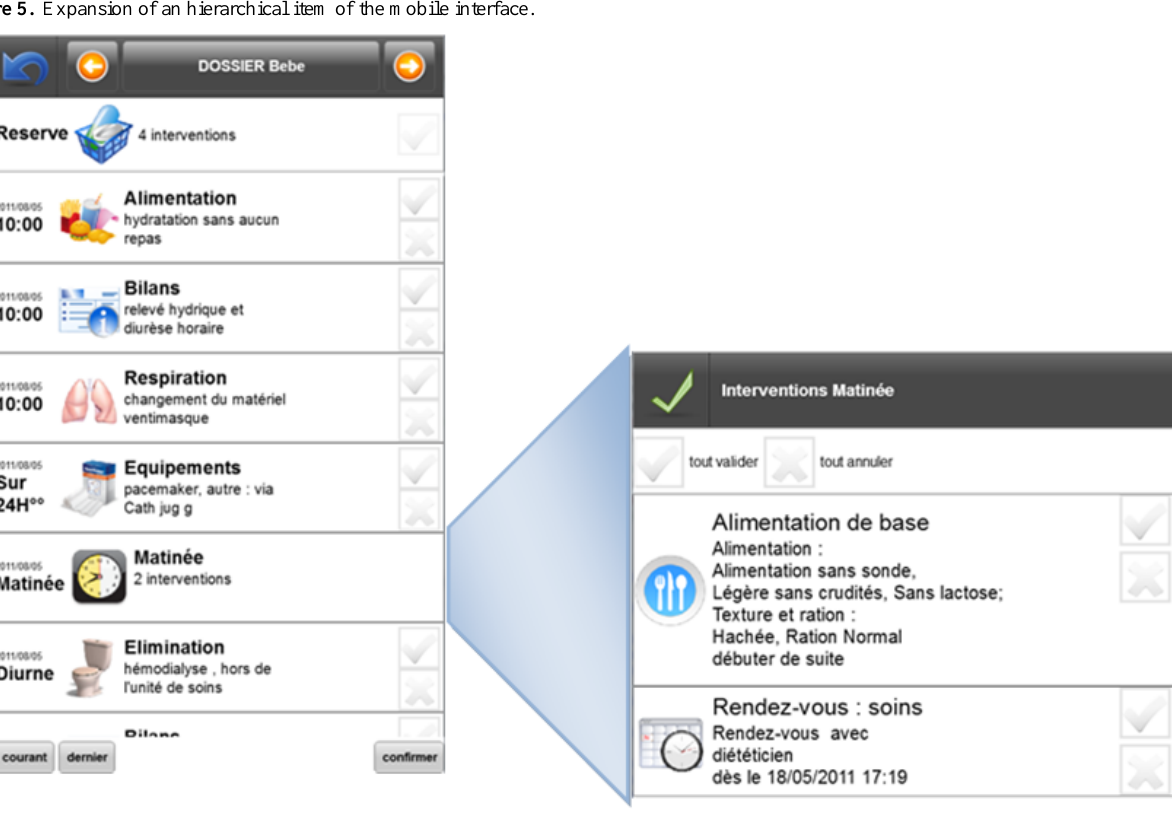
Figure 6. Hierarchical navigation through PRN